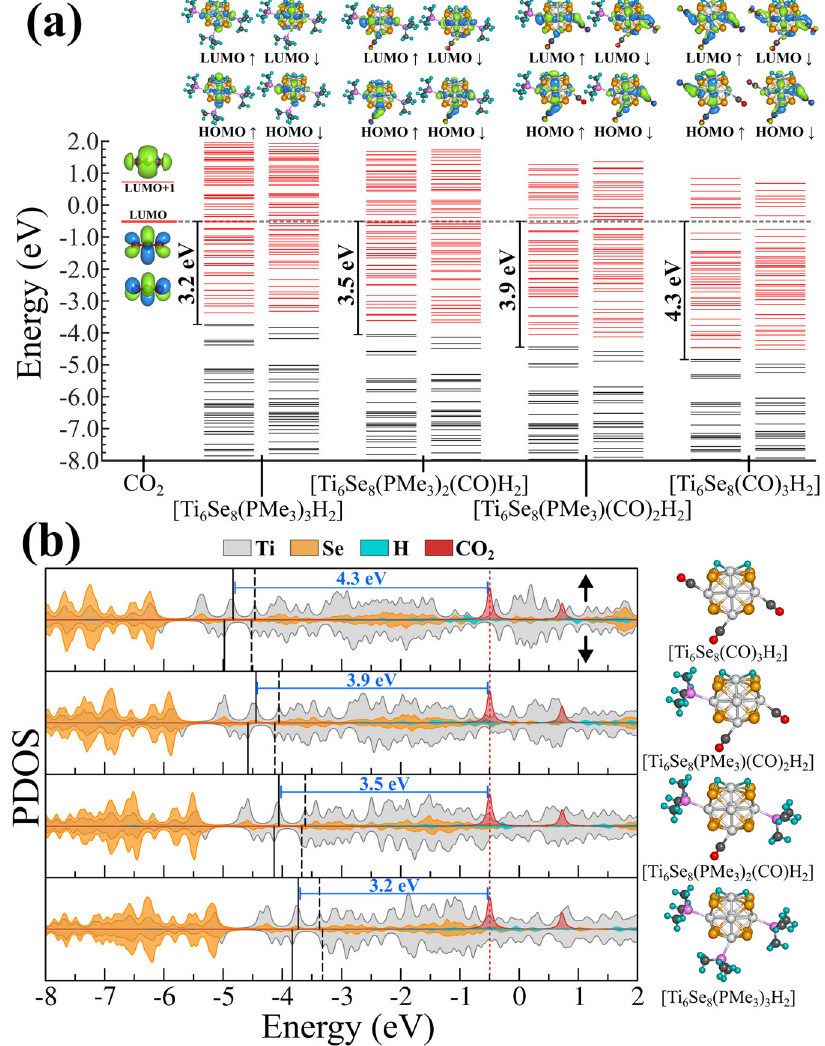
Fig. 6 Ligand induced electronic property alteration of intermediate 2. a Molecular orbital (MO) and b projected density of states (PDOS) diagram of intermediate 2 for the [Ti 6 Se 8 (PMe 3 ) 3-m (CO) m ] (m = 0-3) cluster. The black and red lines in a represents the occupied and unoccupied levels. In b , the location of HOMO and LUMO for each spin channel is marked by solid and dashed black lines respectively. The LUMO of CO 2 molecule is indicated by a dashed red